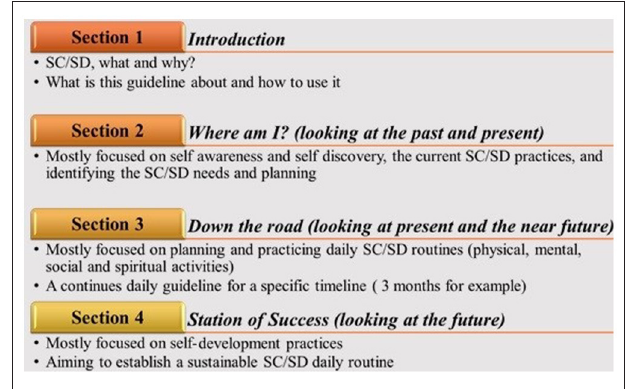
FIGURE 3 | Overview of the guidebook